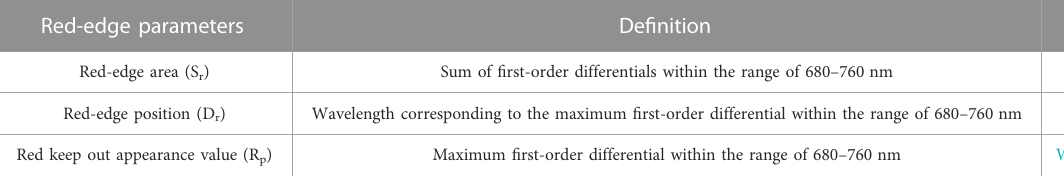
TABLE 1 Red-edge parameters. Red-edge parameters